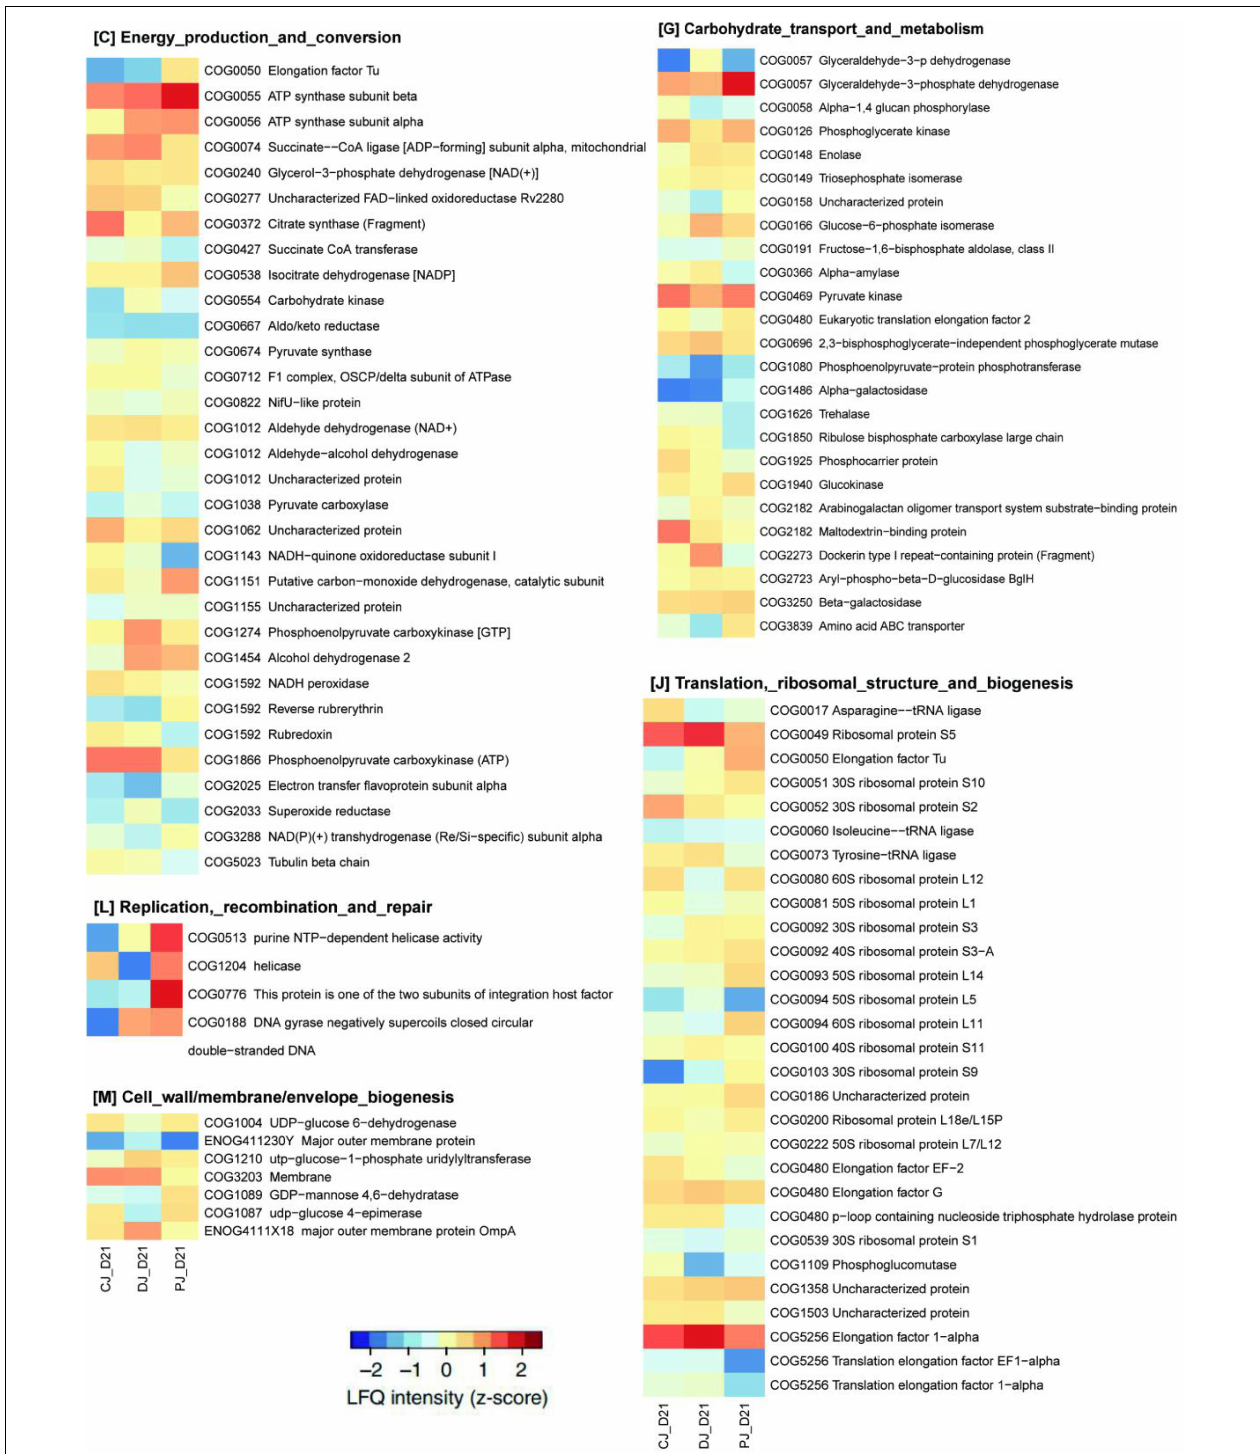
FIGURE 5 | Functional compositions of microbiome in neonatal calves infected by E. coli K99. Heatmap of differentially abundant COGs in neonatal calves. Representative COG categories are shown, and the colors indicate the average label free quantitation (LFQ) intensity for each subgroup of samples. Each row corresponds to a COG with the COG ID and the name